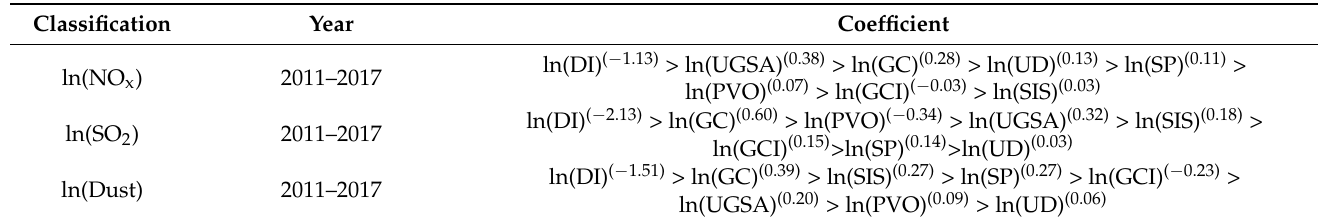
Table 4. Ranking of socioeconomic factors on the impact of three pollutant